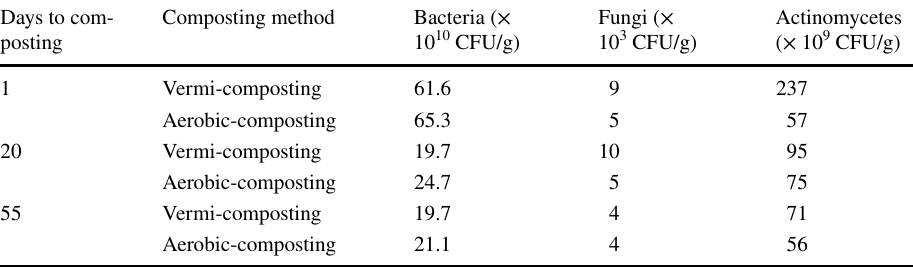
Table 3 Changes in microbial count under different composting methods